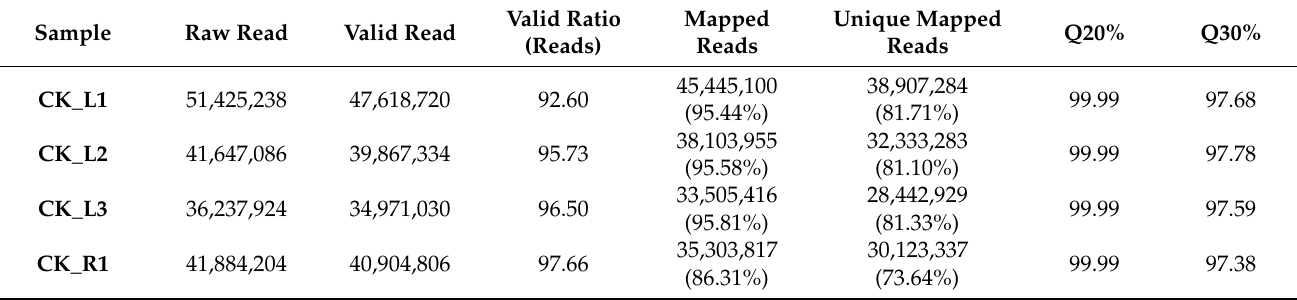
Table 1. Statistics of transcriptome sequencing data. Sample, sample name; Raw Read, the number of reads in total; Valid Read, the number of valid reads after de-junctioning, de-low quality, etc.; Valid Ratio, the proportion of valid reads; Mapped Reads, the number of reads that can be compared to the genome; Unique Mapped Reads, can only uniquely match to one position in the genome; Q20%, the percentage of bases with Q20% quality value ≥ 20 (sequencing error rate less than 0.01); Q30%, the percentage of bases with Q30% quality value ≥ 30 (sequencing error rate less than